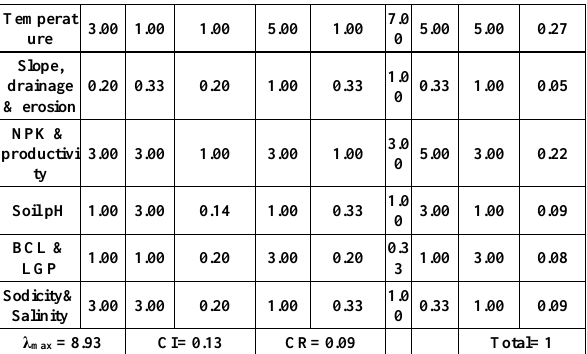
Table 9. Pairwise comparison matrix of selected criteria’s and their weights for Maize